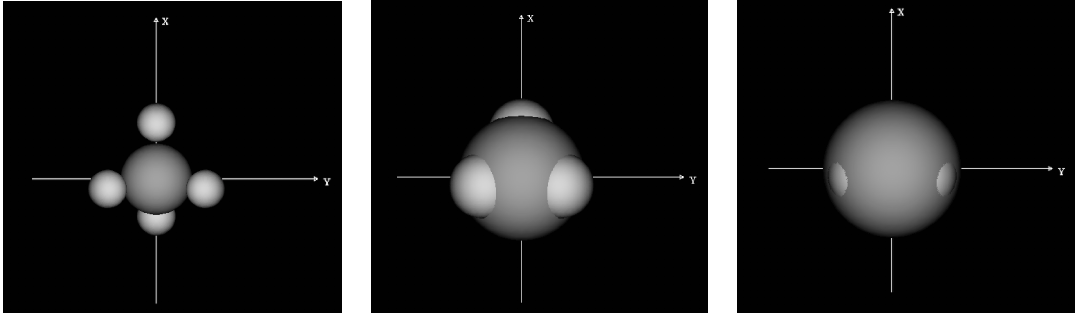
Figure 6. Demonstration of the overlap effect in IAM-PCM: For a particular orientation the effective net capture cross section is obtained from overlapping the atomic cross sections for the carbon atom and the four hydrogens at a collision energy of 70 keV/amu. Left panel for proton impact ( q = 1), middle panel for He 2 + ( q = 2), and right panel for q = 3.